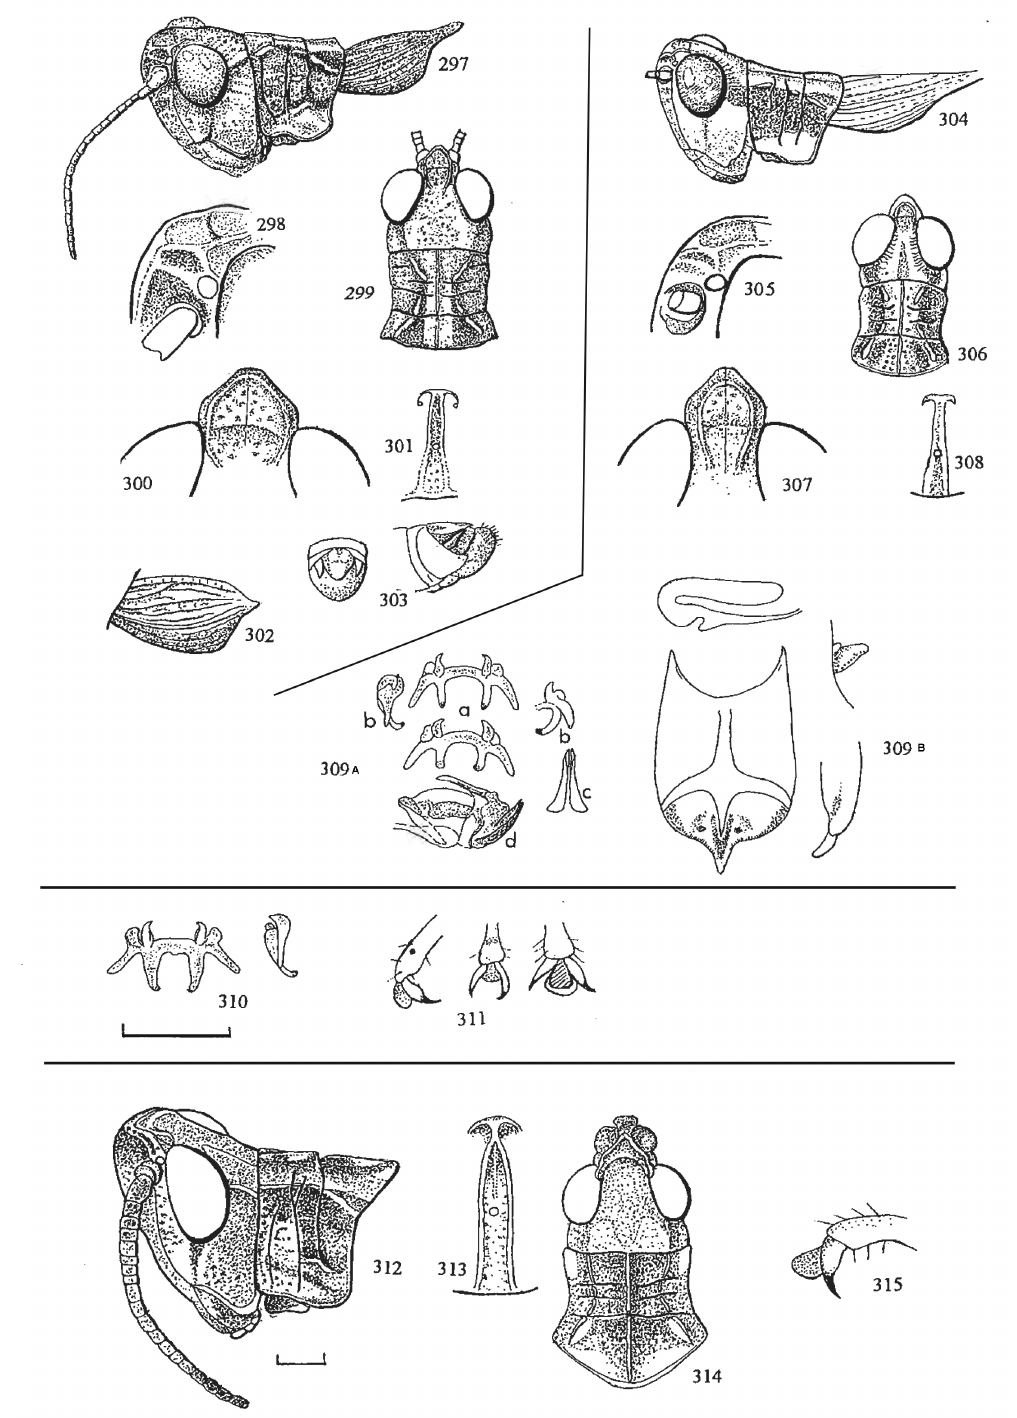
Figs 297–315. Tribe Gymnobothrini. Figs 297–303. Brachybothrus phyllopterus n. gen. et sp. n ., male: 297. Oblique view head, prono- tum and tegmen; 298. Oblique view vertex; 299. Dorsal view head and pronotum; 300. Dorsal view vertex; 301. Frontal ridge; 302. Tegmen; 303. Abdominal apex laterally and dorsally. Figs 304–309. Brachybothrus hola sp. nov.: 304. Oblique view head, pronotum and tegmen; 305. Oblique view vertex; 306. Dorsal view head and pronotum; 307. Dorsal view vertex; 308. Frontal ridge; 309. Geni- talic structures, A. Male, B. Female elements. Figs 310–311. Guichardippus somalicus : 310. Epiphallus; 311. Tarsal claws and pulvillus (lateral view), compared with B. phyllopterus (smallest) and G. rimulatus (larger, seen dorsally). Figs 312–315. Malcolmburria angolensis male: 312. Oblique view head and pronotum; 313. Frontal ridge; 314. Head and pronotum from above; 315. Tarsal claw and pulvillus. Scale lines all l mm: that below Fig. 310 applies to Figs 298, 300, 305, 307, 309–311, 315; that below Fig. 312 applies to Figs 297, 299, 301–304, 308,